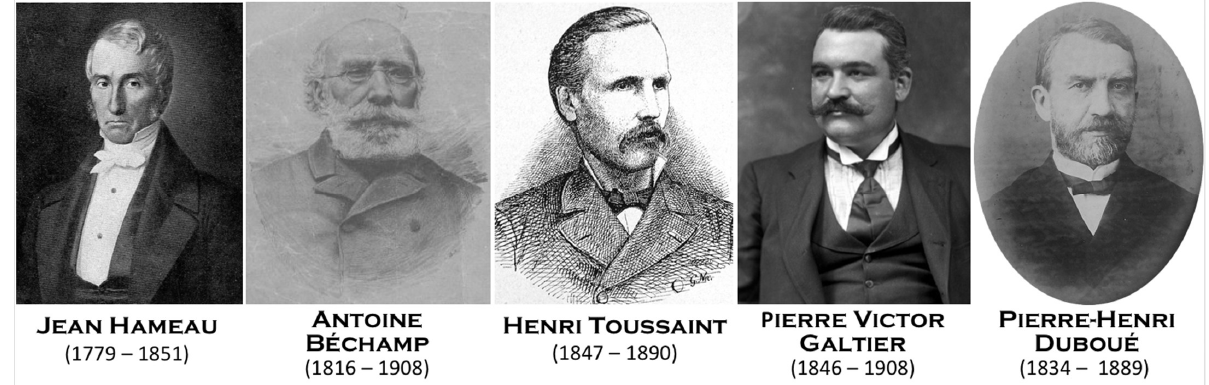
Figure 3. Louis Pasteur faced numerous precursors, opponents, and competitors. Some were wrong, but a few, particularly Hameau, Béchamp, Toussaint, Galtier, and Duboué, were right despite being unknown or poorly recognized by Louis Pasteur (© Wikipedia/© https://gw.geneanet.org accessed on 19 March 2022).